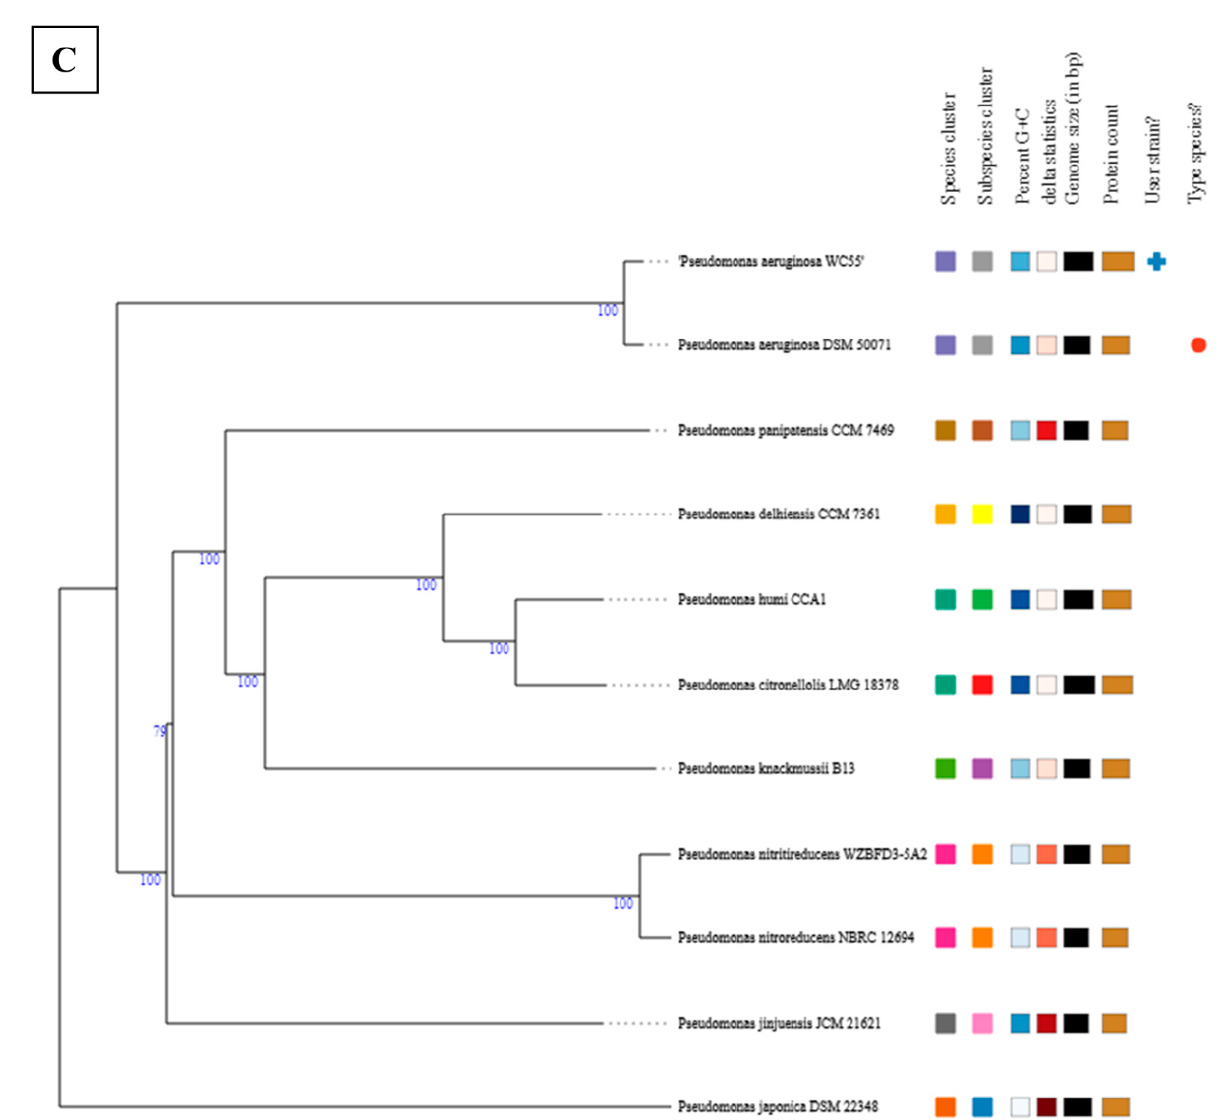
Figure 2. Phylogenomic trees obtained from the TYGS pair-wise comparison of Pseudomonas alcaligenes strain OT69 ( A ), Pseudomonas stutzeri strain MF28 ( B ) and Pseudomonas aeruginosa strain WC55 ( C ), respectively. The + symbol indicates user strain, which represent the isolates obtained in this study and used for this analysis.